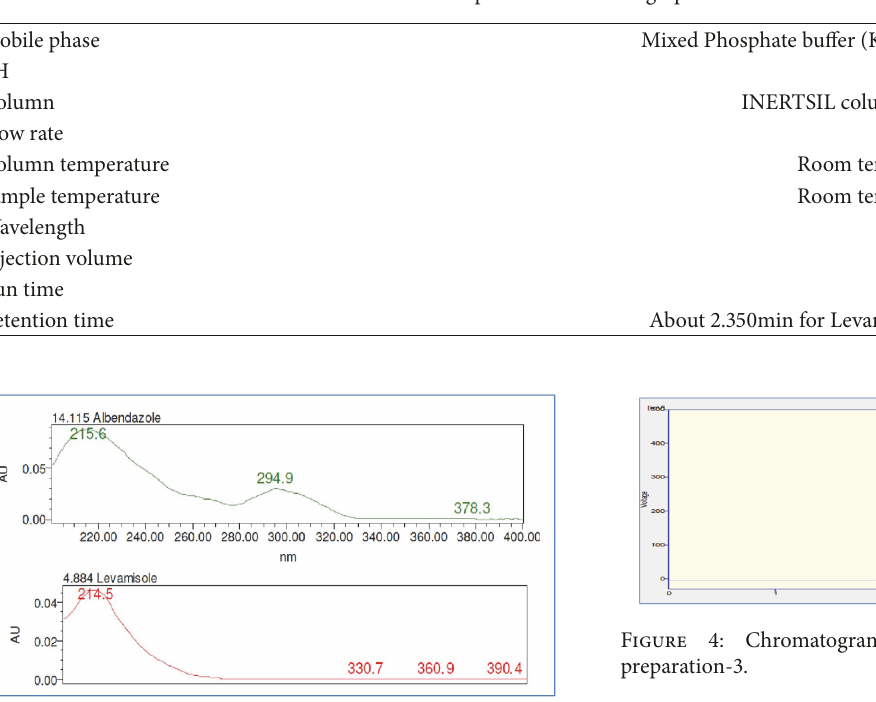
Figure 2: Individual UV spectrum of levamisole and albendazole.